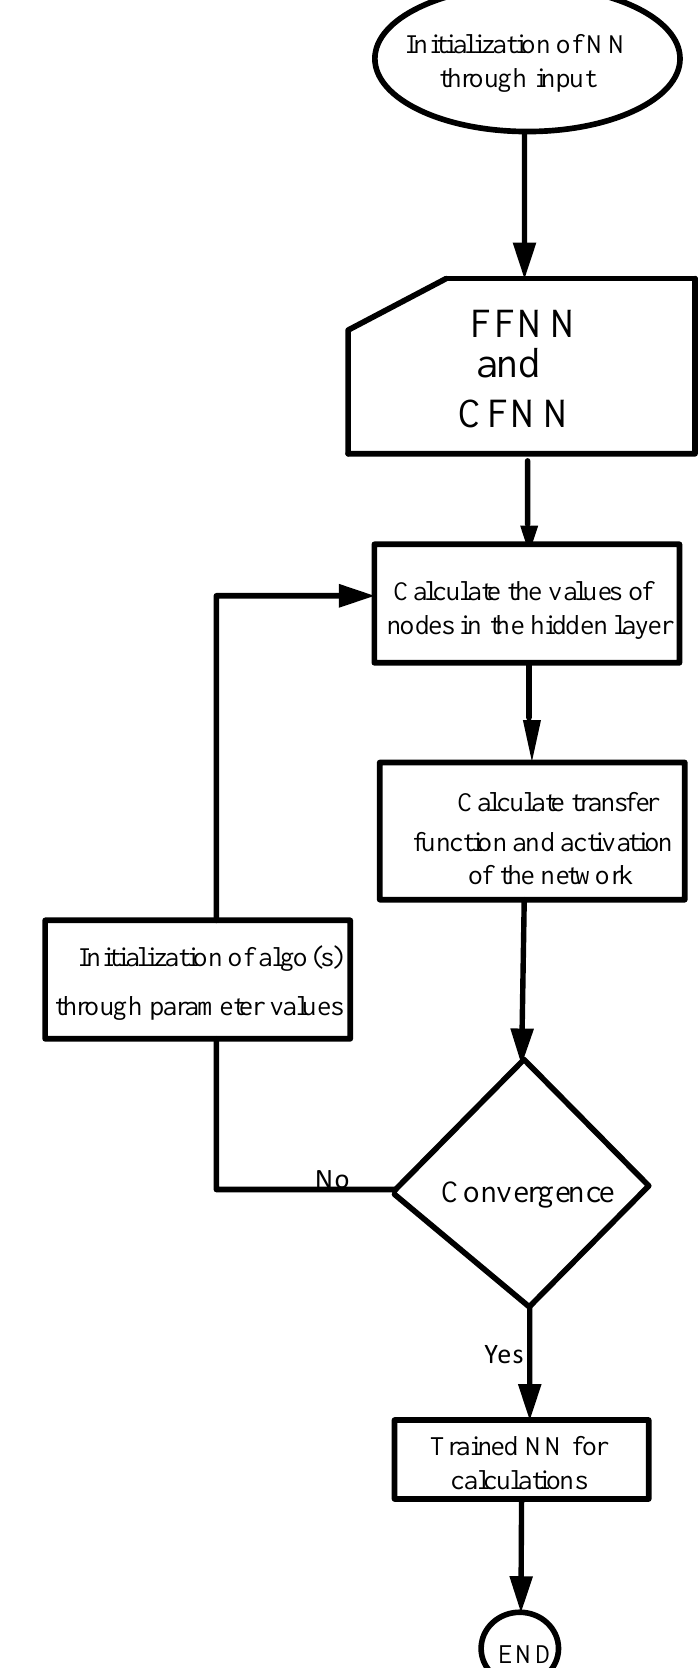
Figure 8. Flow Chart of NNs trained through HPSOBA, MHPSO-BAACs, and PSO. The real values of the wind speed for the next five months of 2019 are used for the accuracy determination using the Equation (5). Algorithm 3 gives the pseudocode of the algorithms used for training the FFNN and CFNN.